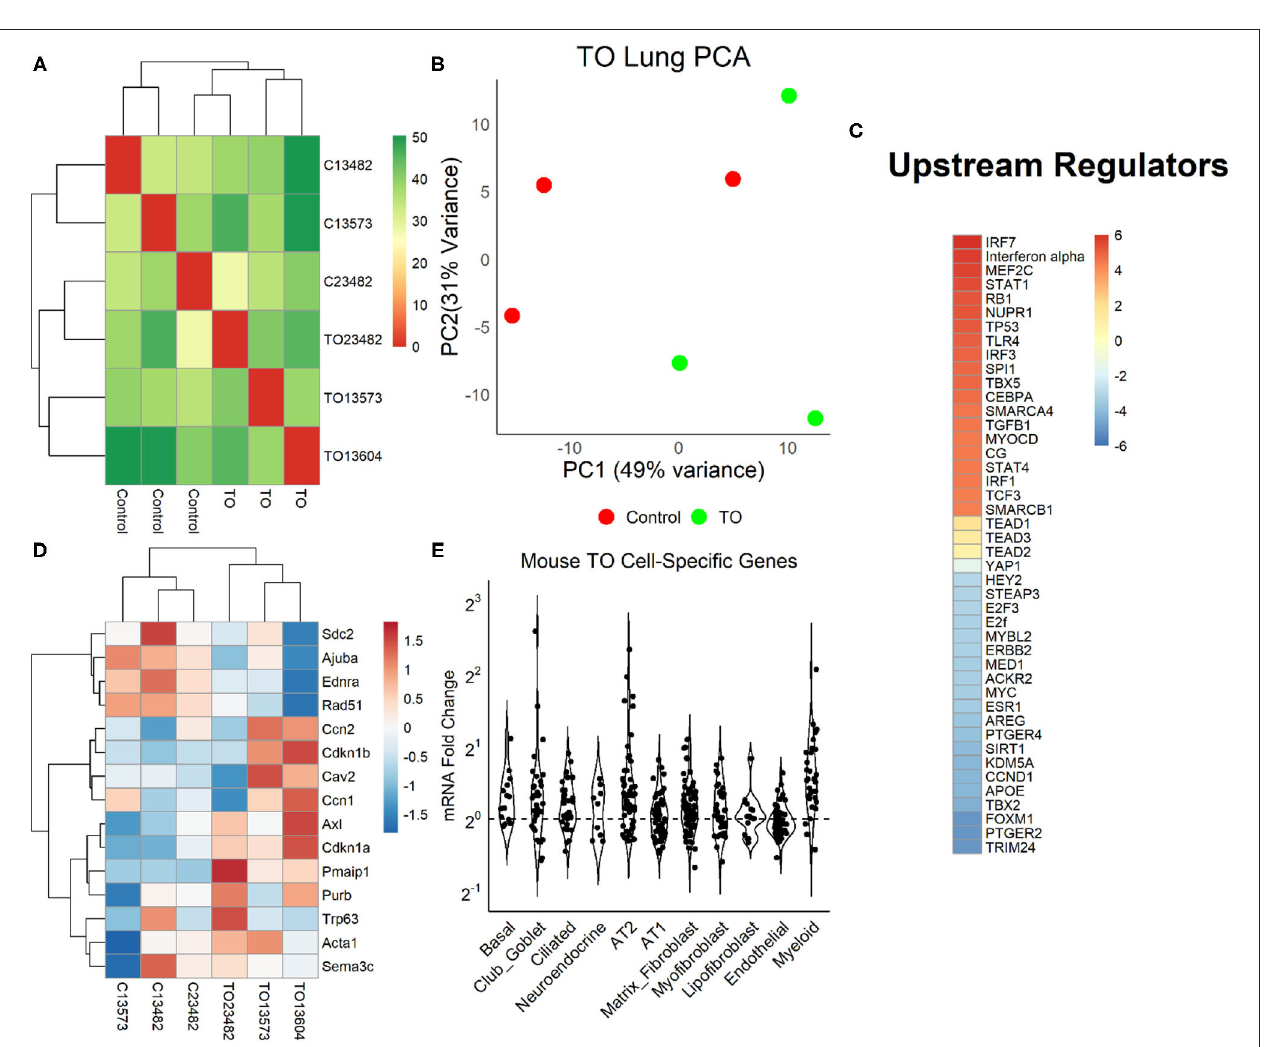
FIGURE 3 | growth factor ( CTGF ) (E) and p63 (F) . Both are Yap target genes. Comparison is by Welch’s t -test. (G) Mice with hemizygous deletion of lung epithelial cell Yap at baseline ( n = 9) and after TO ( n = 5) showed similar numbers of basal cells to wild-type (WT) mice. Lung epithelial cell-specific deletion of Yap without TO ( n = 4) or with TO ( n = 5) both had basal cell frequencies comparable to control hemizygous and WT mice. * p < 0.05, ** p < 0.01 by Holm–Sidak post-hoc test. (H,I) Compared to wild-type (H) , mice with conditional deletion of Yap from the lung epithelium (I) had reduced abundance of basal cells as assessed by nerve growth